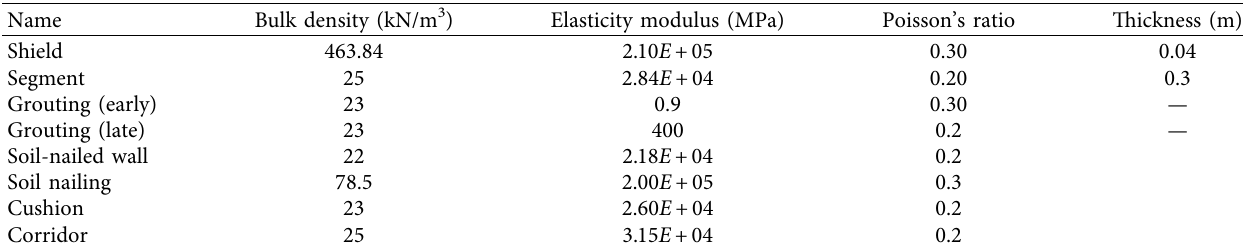
Table 3: Parameters of structures of metro tunnel and utility tunnel.